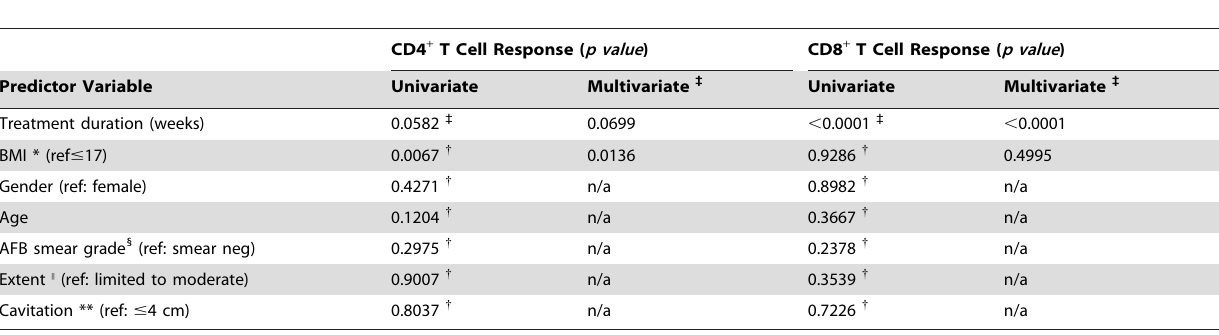
Table 3. Univariate and multivariate analyses of predictors of the Mtb specific T cell response among HIV negative, smear positive, culture confirmed pulmonary TB patients undergoing antituberculosis